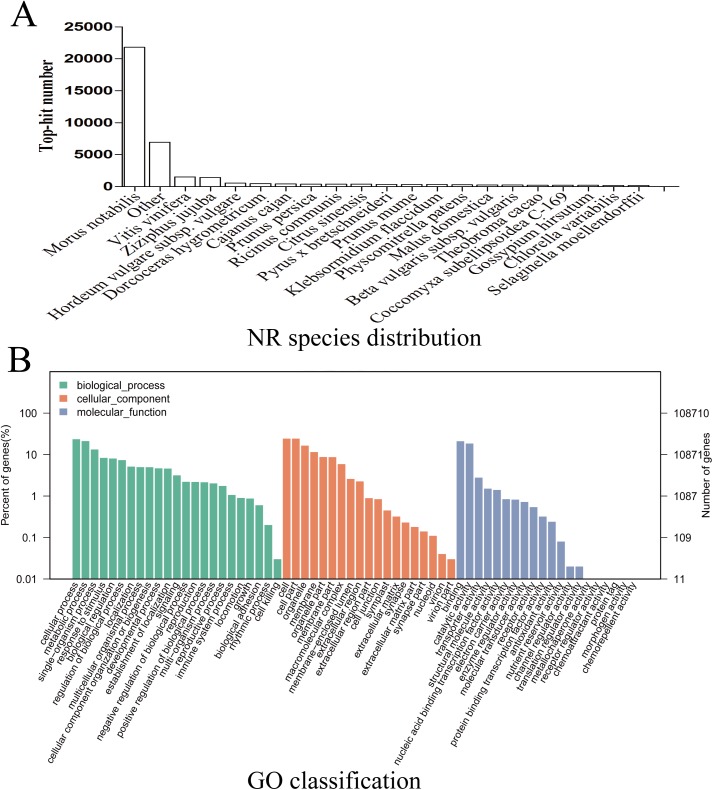
NR species distribution and GO classification of RNA-Seq data.(A) Species distribution of the top 20 BLAST hits for total homologous sequences. (B) Percentage of sequences enrichment in GO classification.